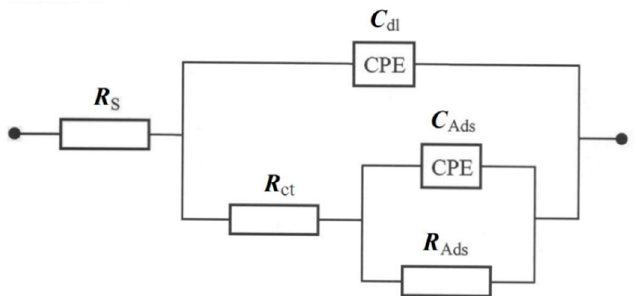
Figure 5. Equivalent circuit for impedance analysis of the OER process. Two CPE-R element equivalent circuit was used for fitting the impedance data for as received Ni foam, Co- and Mo-activated Ni foam electrodes, obtained in 0.1 M NaOH solution. The circuit includes two constant phase elements (CPEs), to account for distributed capacitance; R ct , C dl , R Ads , and C Ads (as CPE) elements correspond to the charge-transfer resistance, interfacial double-layer capacitance, resistance and capacitance adsorption components of reaction intermediates; R s is solution resistance.